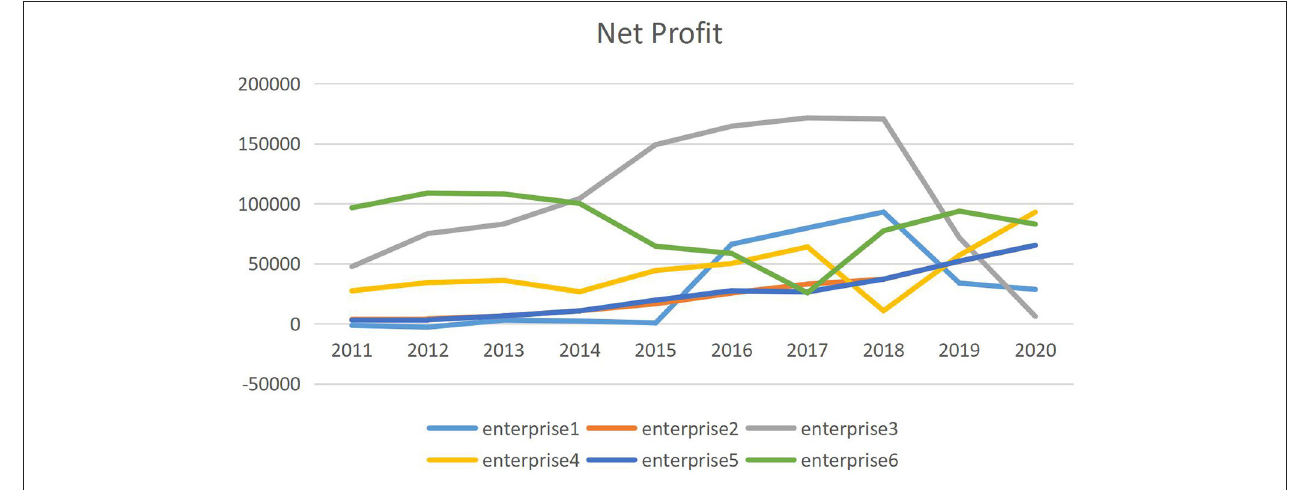
FIGURE 1 | Trends in net profit of bid-winning enterprise from 2011 to